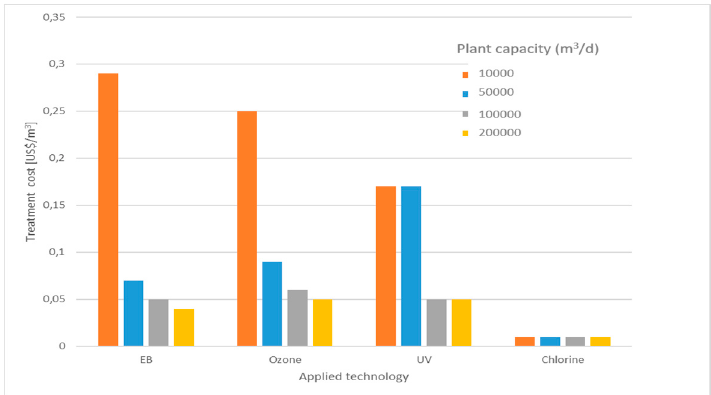
Figure 5. Specific total disinfection costs (US$/m 3 treated) of urban effluents for irrigation reuse according to different technologies (data from [102]).